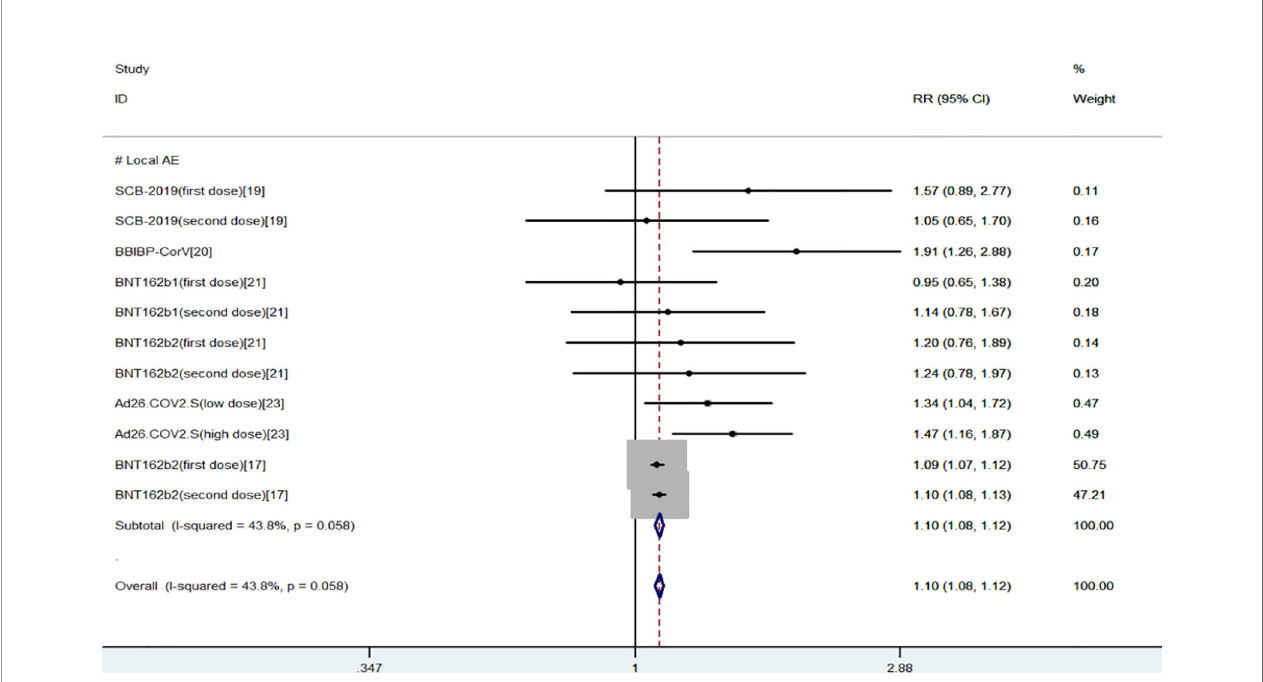
FIGURE 4 | Meta-analysis of local AEs between the experimental group (young adults) vs control group (older adults).